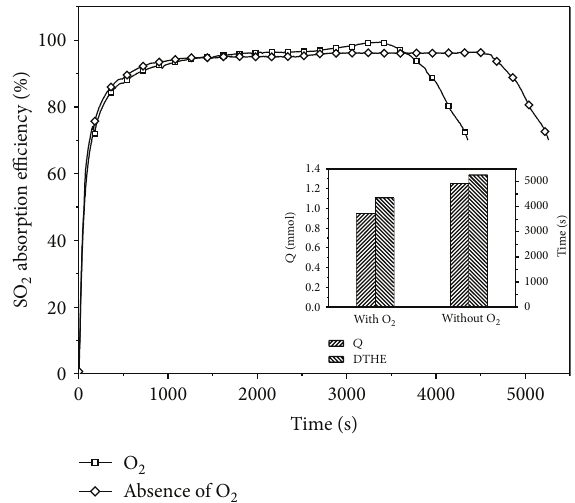
Figure 5: The effects of O 2 (SO 2 , 2500 ppm; gas flow, 0.12m 3 /h; absorption solution, 100mL; 298 K). The inset shows the absorption amount of SO 2 and